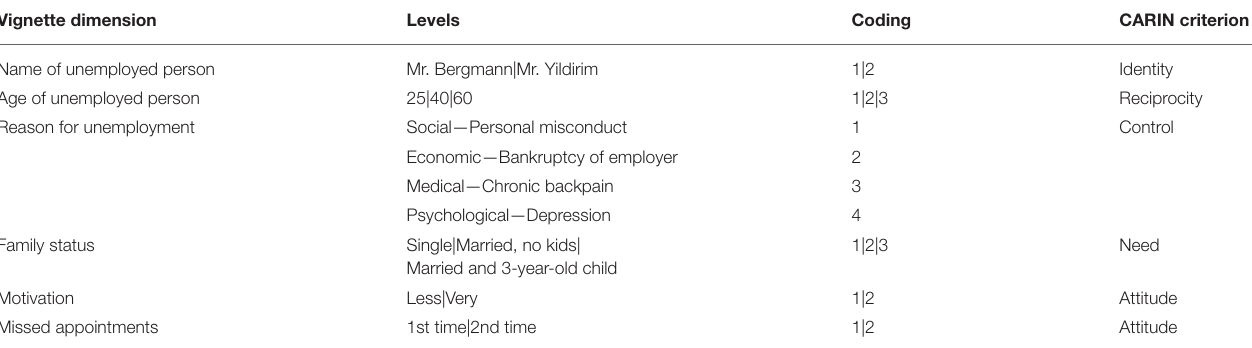
TABLE 1 | Vignette dimensions, levels, and